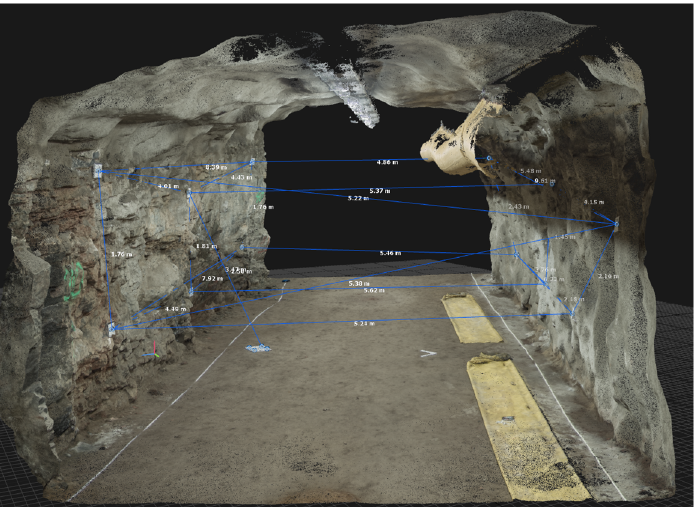
Figure 9. Control distances were measured between markers mounted on tunnel walls and compared with the calculated distances on the reconstructed 3D model. Table 4. Measured and calculated control distances and the RMSE.